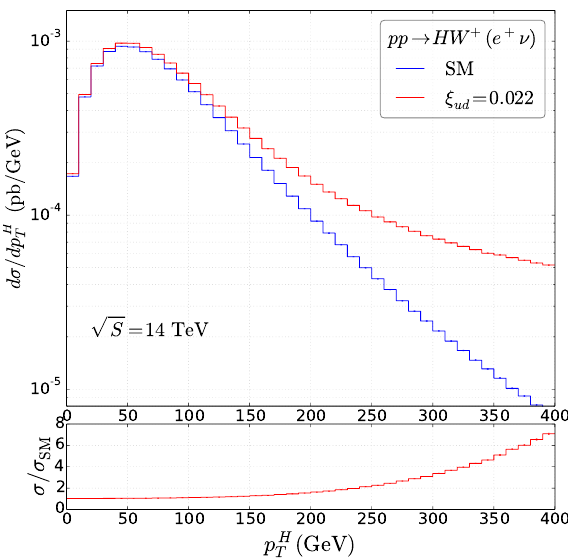
p S = 14 TeV, di(cid:11)erential